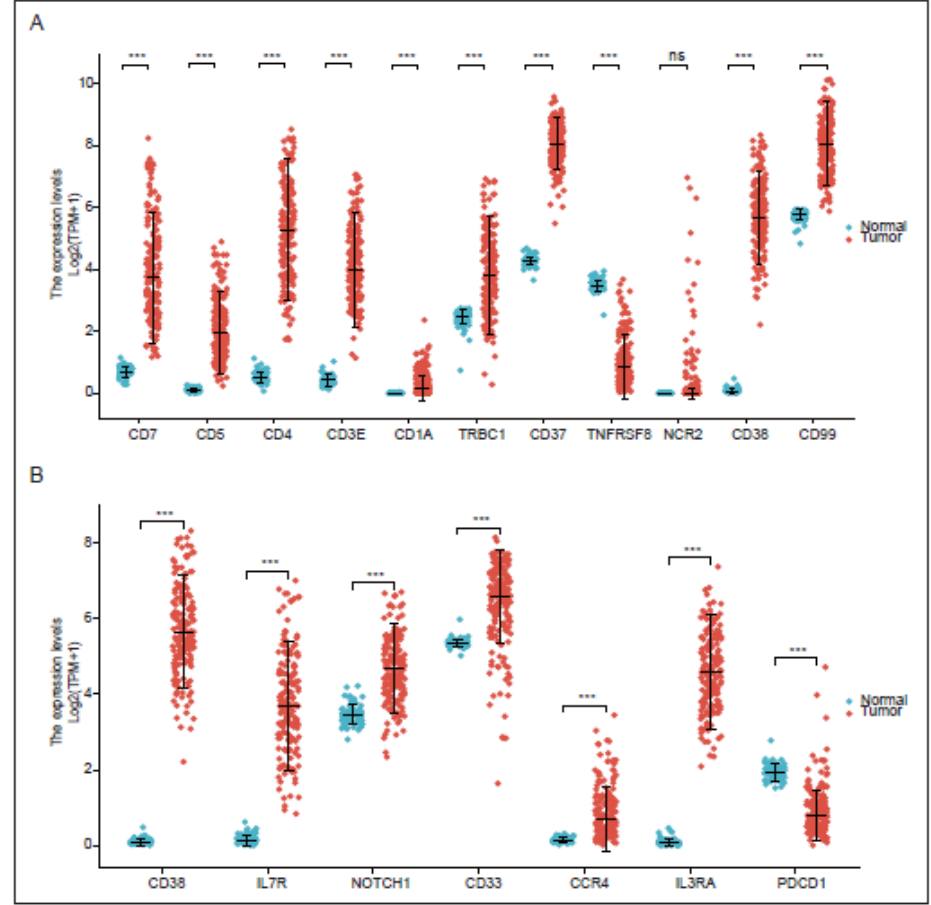
Figure 6. The expression of potential target antigens between tumor samples and normal samples, data from Cancer Cell Line Encyclopedia (CCLE). ( A ) The targets for CAR T therapy. ( B ) The targets for monoclonal antibody therapy. Data are mean ± SD (Two-tailed unpaired Student’s t test, *** p <